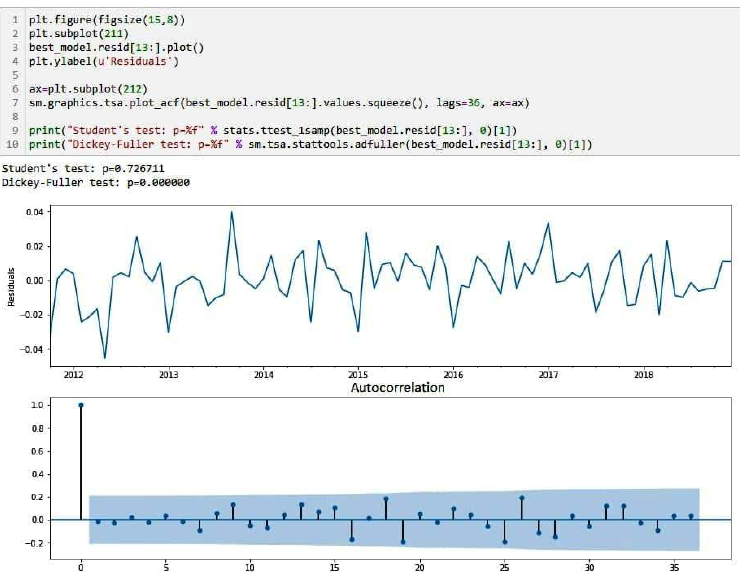
Figure 12. Results of the application of the Dickey–Fuller test and the Student’s test. Building a